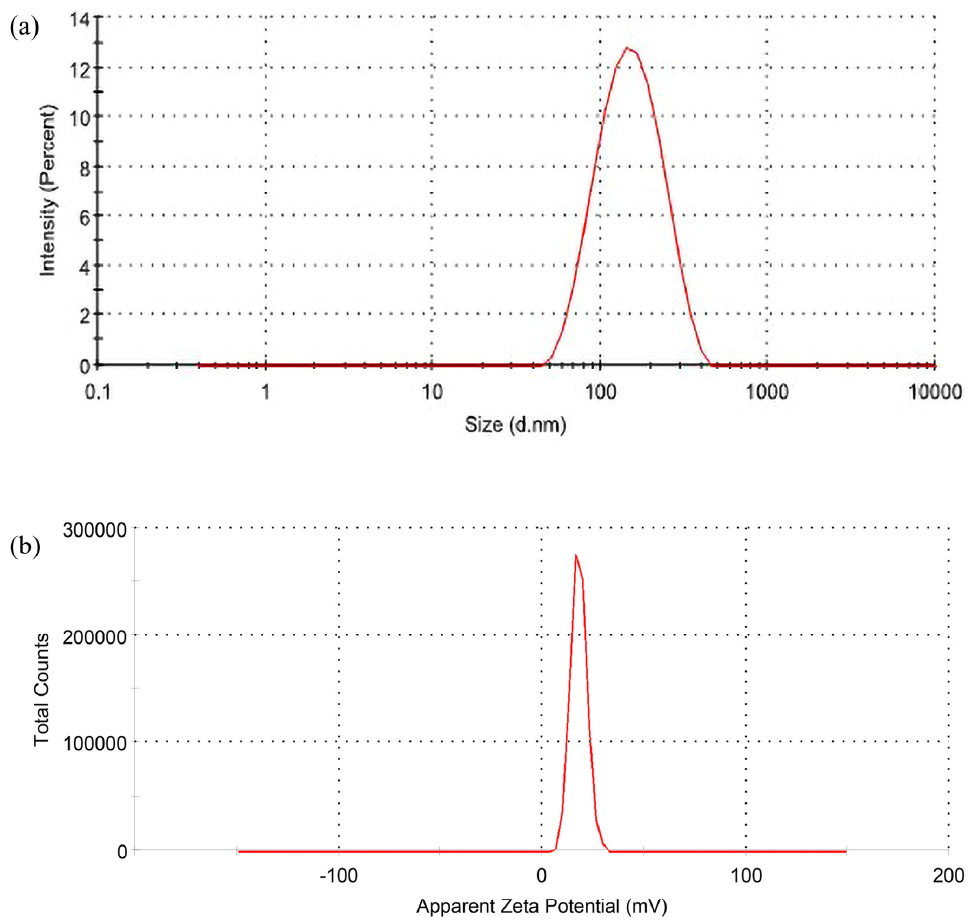
Figure 2. ( a ) Particle size distribution and ( b ) the zeta-potential of optimized Figure 2. (a) Particle size distribution and (b) the zeta-potential of optimized CUR/LCSNPs. Table 5. Predicted and observed response of CUR/LCSNPs with maximum desirability suggested by the Box-Behnken statistical design.